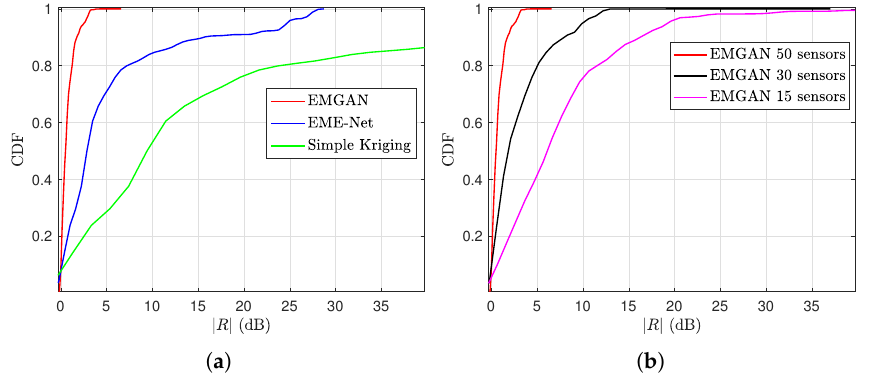
Figure 10. CDF of the models as a function of the absolute ratio | R | between the reconstructed map and real map: ( a ) Different models; ( b ) EMGAN with varying numbers of sensors.